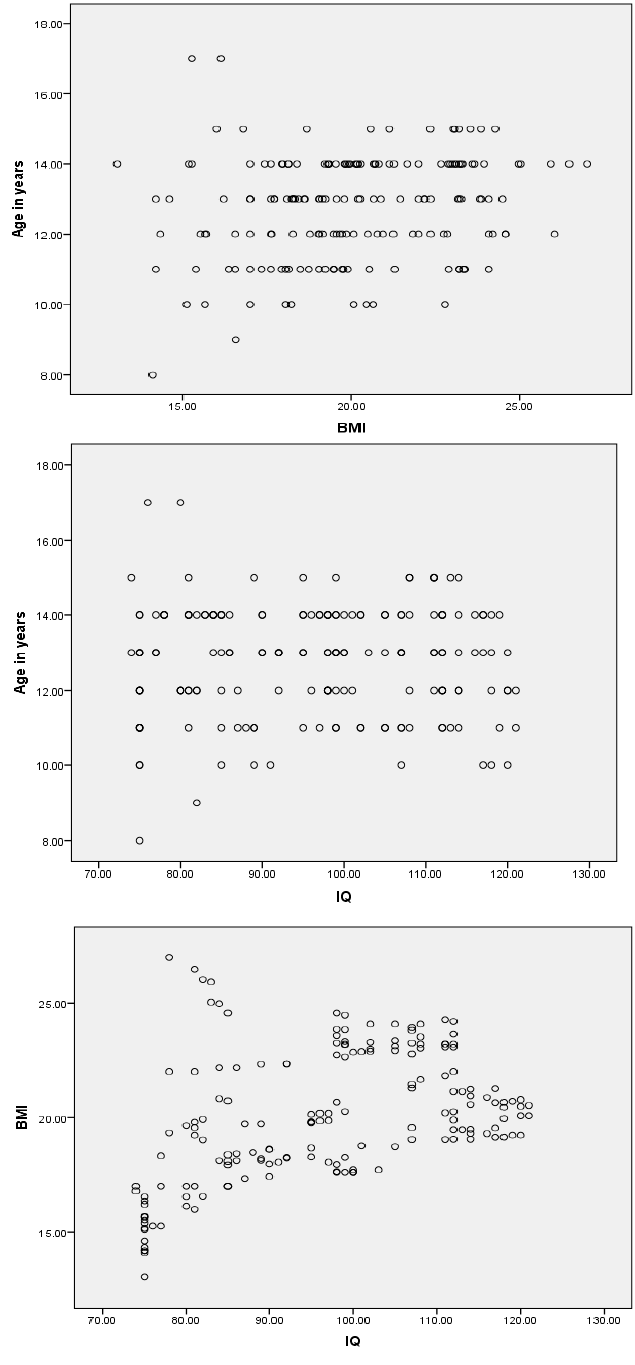
Figure 2. Association between age, BMI and IQ.